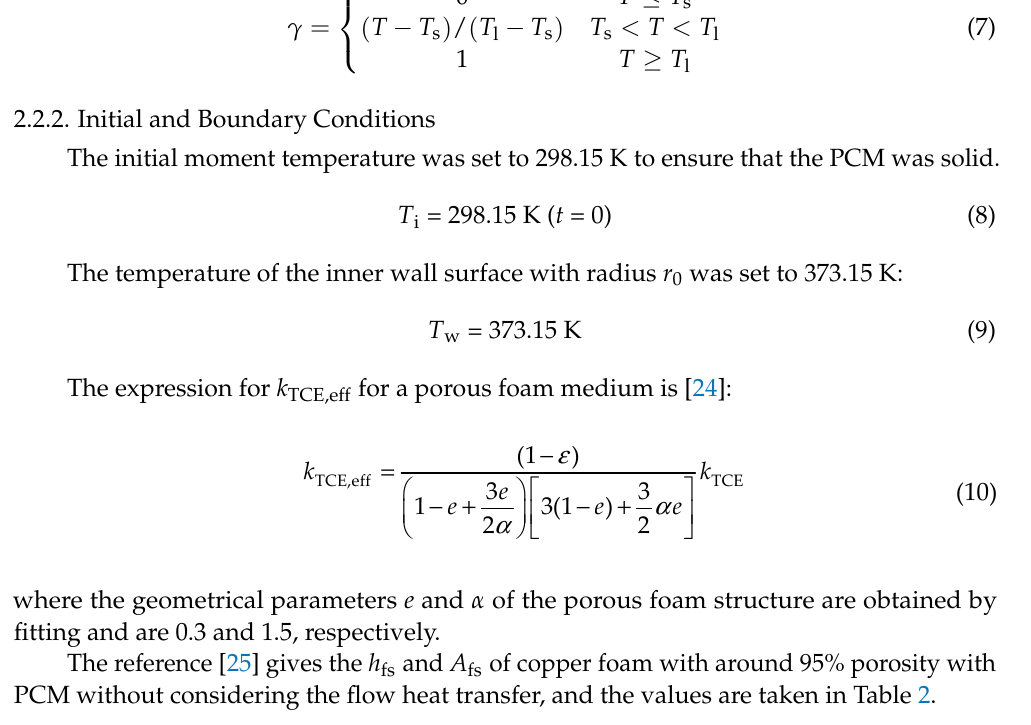
Table 2. Local non-equilibrium heat transfer parameters of copper foam with different pore densi- ties.